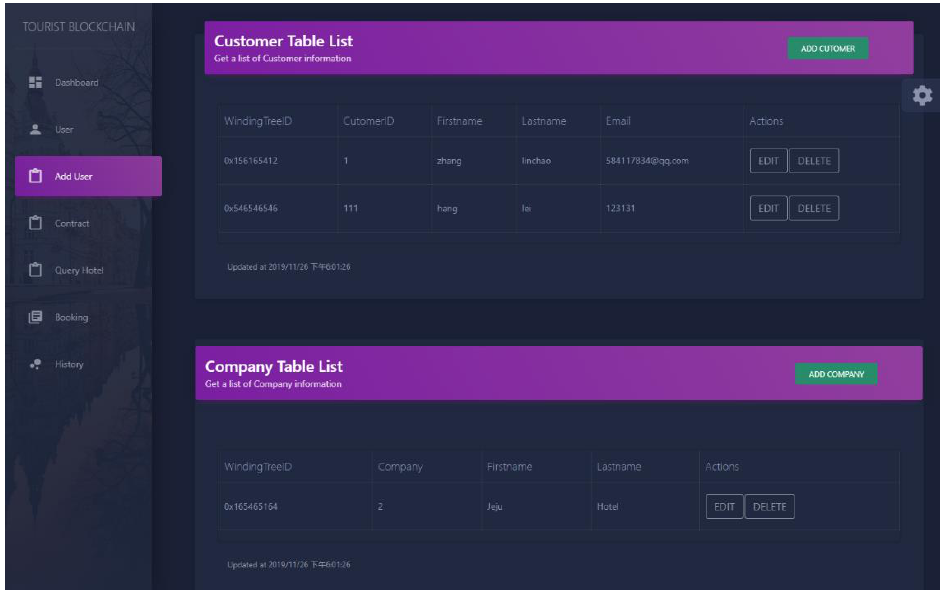
Figure 21. Screenshot of the participant dashboard.